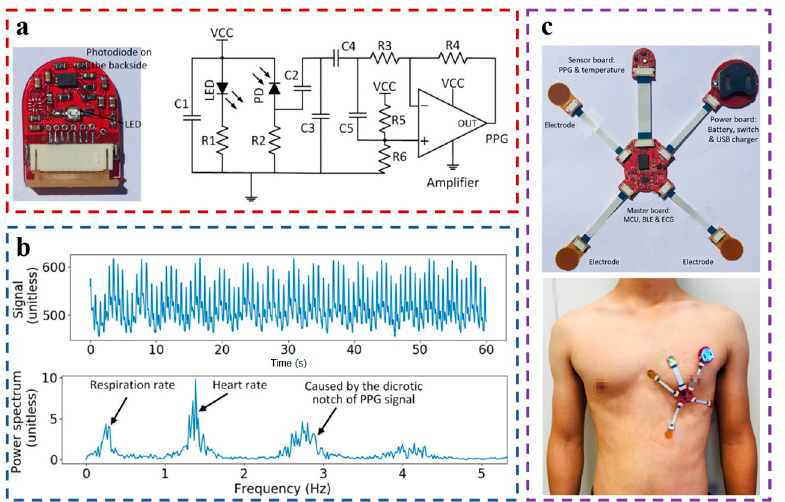
Figure 6. ( a ) PPG sensor (20 mm × 16 mm) and circuit diagram of the active low-pass filter; ( b ) Signals collected by the PPG sensor and spectrum analysis of the PPG signals after removing the dc component; ( c ) Rigid-flex design of the sensor patch for health monitoring. Reproduced with the permission of [64]. Copyright 2020, IEEE.